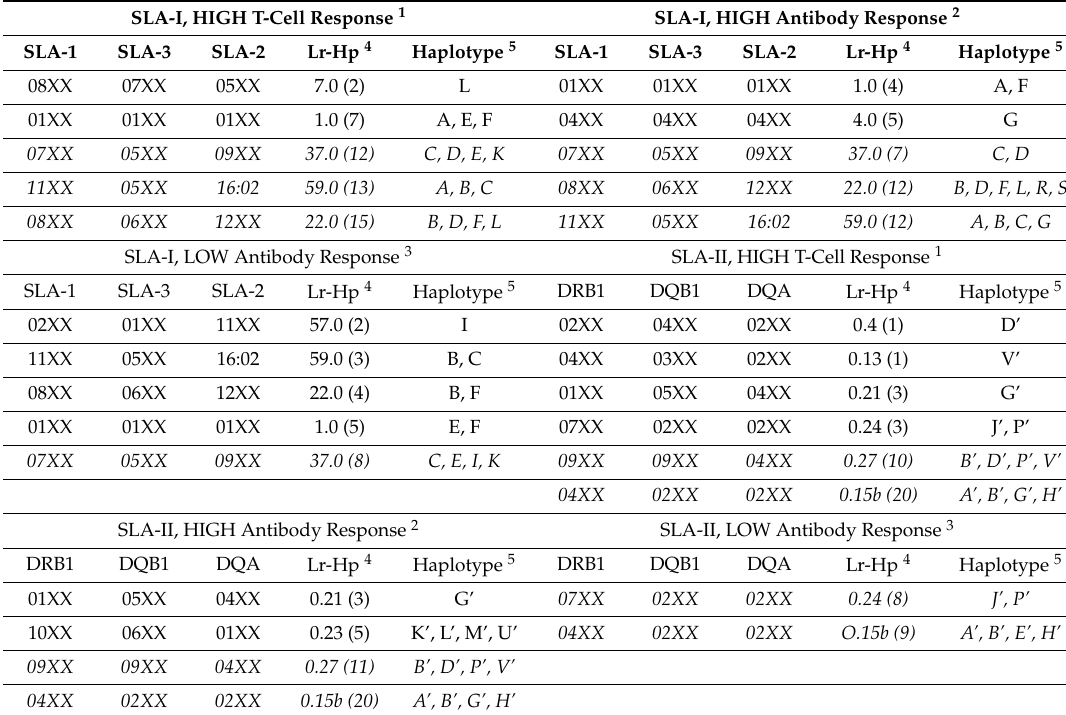
Table 5. Shared allele-groups and Low-resolution Haplotypes among the T-cell high responding animals and antibody high and low responder animals.